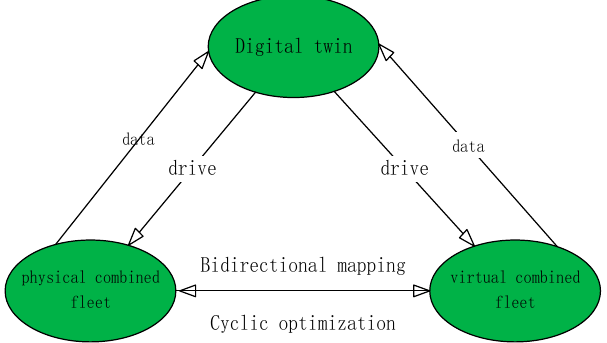
Figure 1. Structure of the integration of the virtual and real integration combined vehicle fleet.